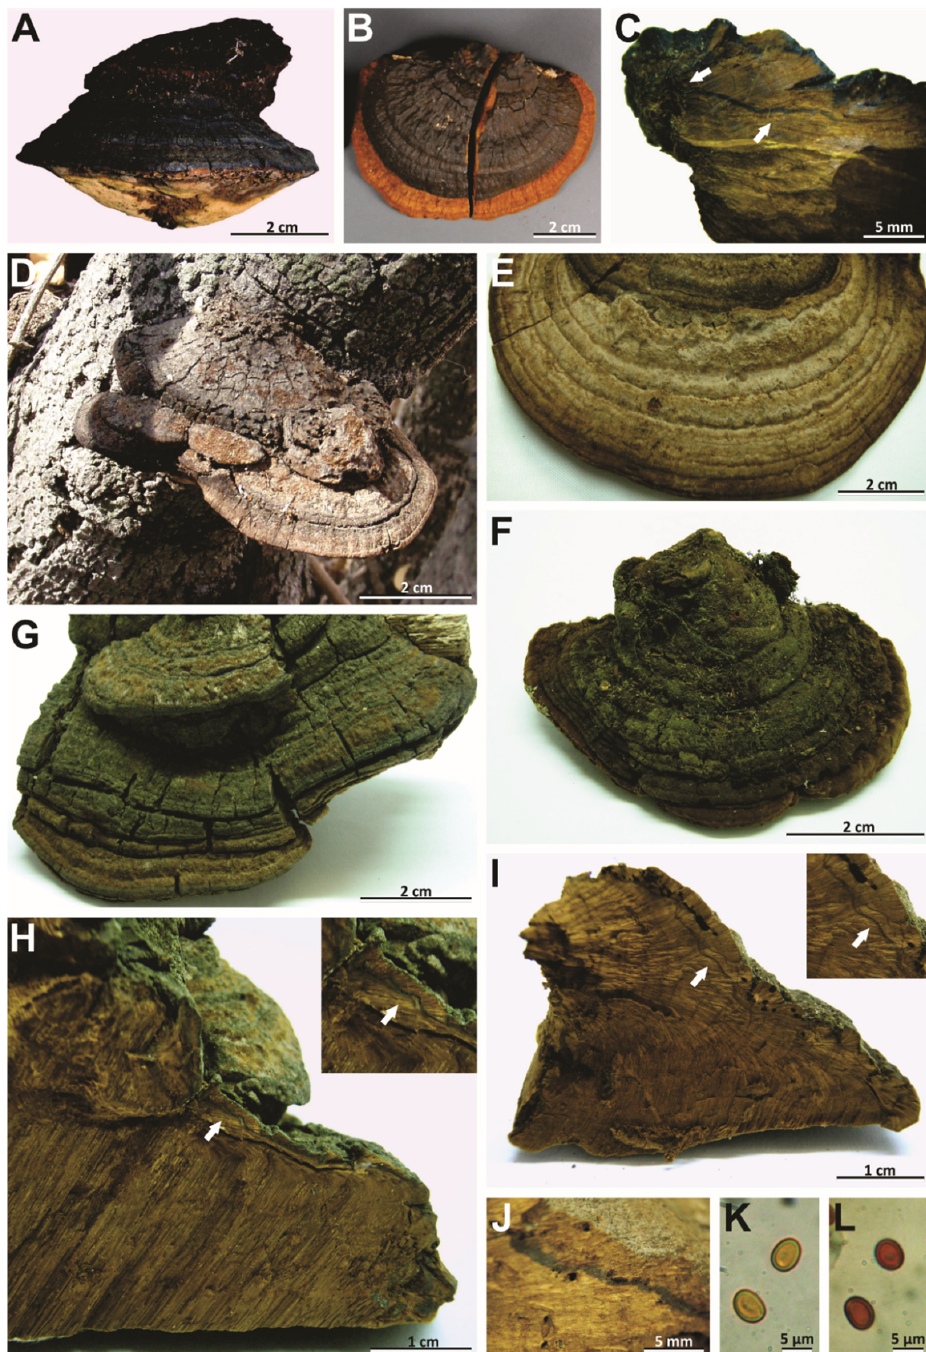
Figure 6. Morphological features of Phellinotus neoaridus and P . teixeirae . ( A – C ) Phellinotus neoaridus . ( A ) HUEFS 112186: basidioma with rimose and black pileal surface; ( B , C ) URM 80422. ( B ) basidioma; ( C ) the context with detail of a dark line and mycelial core. ( D – L ) Phellinotus teixeirae . ( D – J ) basidioma. ( D ) USM 250528 (holotype); ( E ) URM 80768: young specimen with pubescent, ondulate, slightly zoned, and brown pileal surface; ( F ) CTES 569014: specimen with slightly cracked pileal surface; ( G ) CTES 515266: well-developed specimen with rimose and grayish brown pileal surface. ( H – J ) Perennial basiomata with dark lines in the context and tubes indistinctly stratified. ( H ) CTES 515266; ( I ) CTES 569014; ( J ) USM 250528 (holotype). ( K , L ) Basidiospores. ( K ) in water; ( L ) in